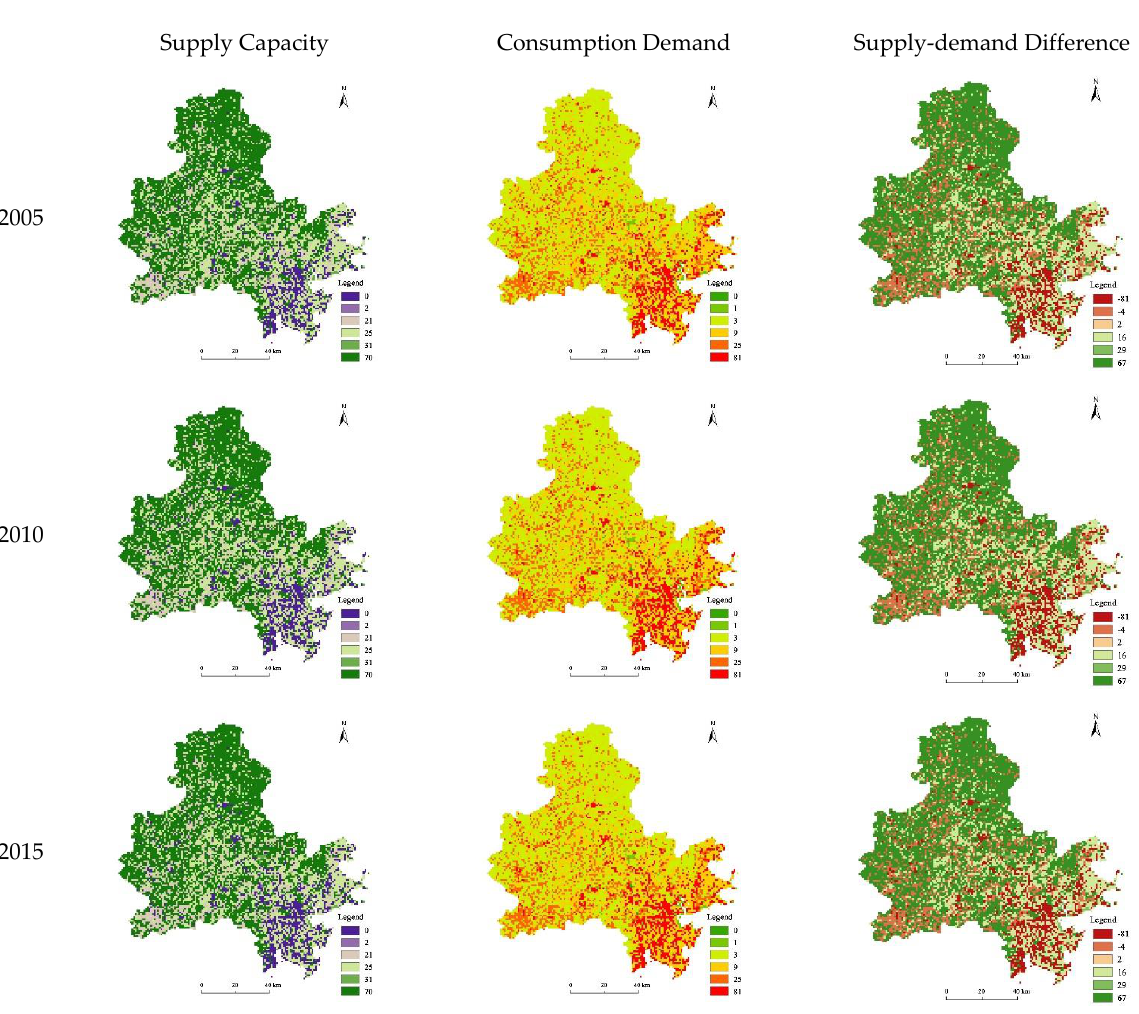
Figure 3. Spatial – temporal pattern of supply capacity, consumption demand, and supply-demand Figure 3. Spatial–temporal pattern of supply capacity, consumption demand, and supply-demand difference of ecosystem services in Quanzhou. difference of ecosystem services in